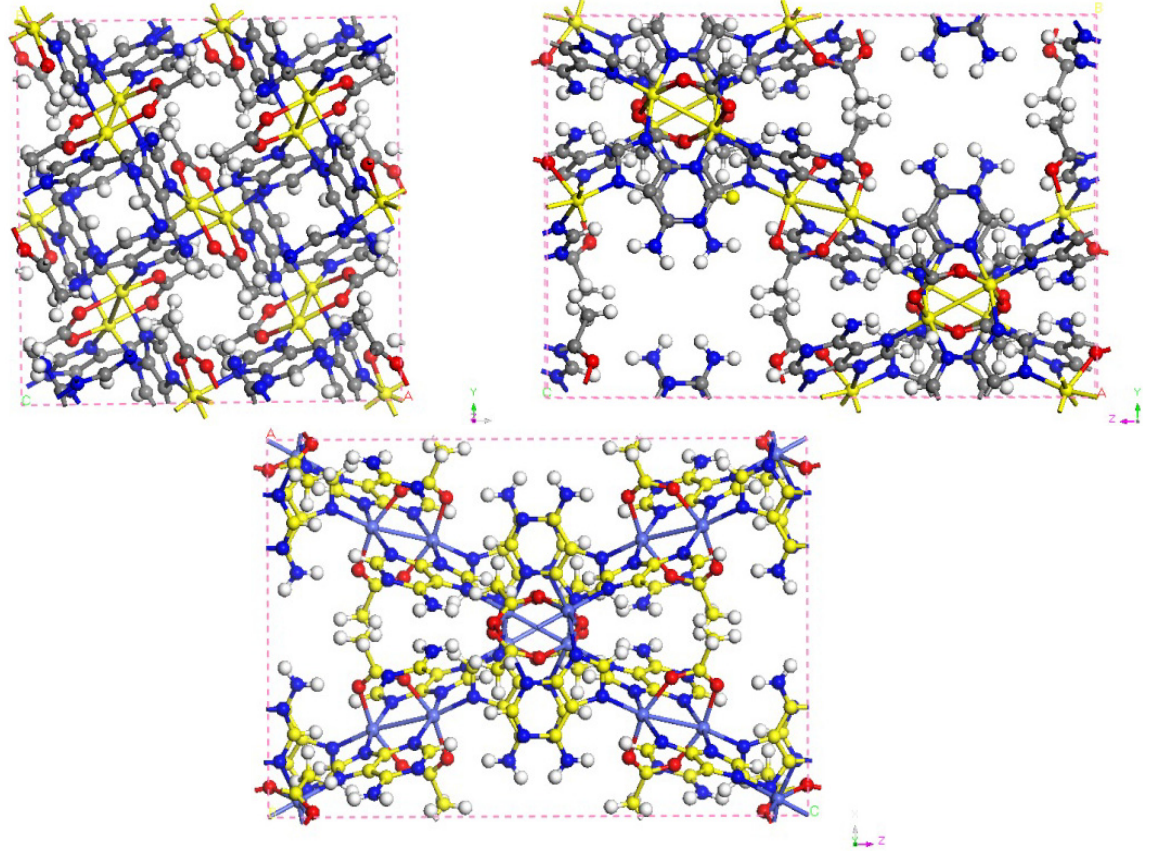
Figure 12. Unit cell crystal structure of bio-MOF-11 used in the simulations (Co, yellow; C, grey; H, white; O, red; and N,